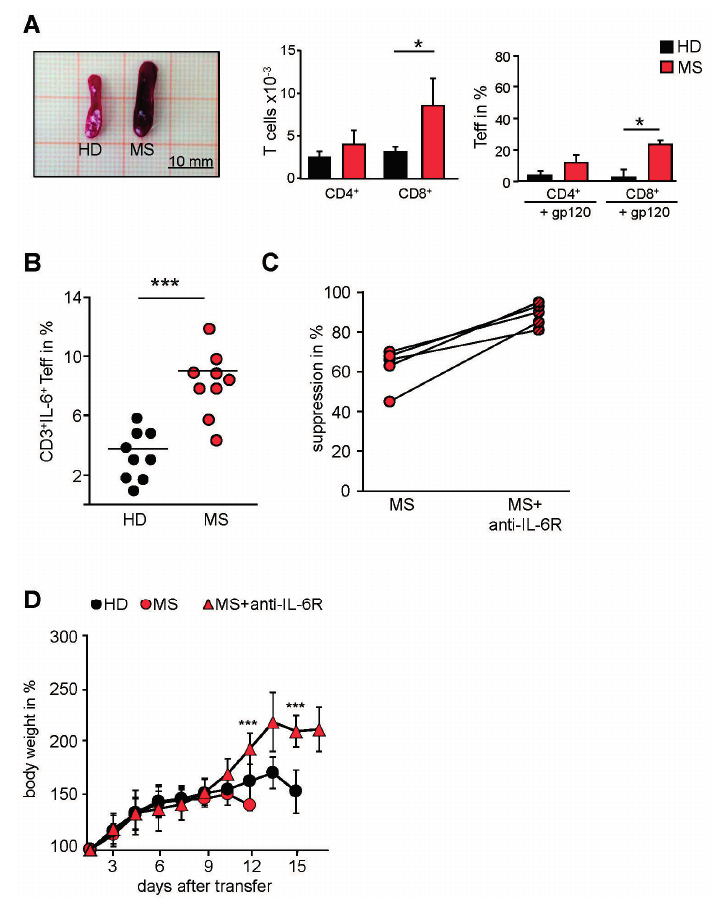
Figure 3. In vivo blockade of the IL-6 receptor by Tocilizumab ameliorated systemic inflammation. ( A ) Treg were depleted within PBMC of HD (black) or MS (red) and replaced with the same amount of Treg from an independent HD. Subsequently, 5 × 10 6 cells were injected with or without gp120 (5 μ g/mouse) intraperitoneally into newborn NOD/ Scid γ c − / − mice. Seven days after transfer spleens were removed and proportion of CD4 + and CD8 + T cells was analyzed by flow cytometry; p -values relative to mice injected with HD-PBMC: * p < 0.05; ( B ) MS PBMC were cultured in vitro with Treg and stimulated with anti-CD3 mAb in presence (striped) or absence (red) of anti-IL6R mAb. Dots show percentage of suppression in presence of Treg normalized to PBMC alone ( n = 5), *** p < 0.001; ( C ) Treg were depleted within PBMC of HD (black) or MS (red) and replaced with the same amount of Treg from an independent HD. Subsequently, 5 × 10 6 cells were injected with or without gp120 (5 g/mouse) intraperitoneally into newborn NOD/ Scid γ c − / − mice. Seven days after transfer spleens were removed and IL-6 production of reisolated T cells was determined by flow cytometry. Each point represents an individual mouse, line indicates mean value; ( D ) Treg were depleted within PBMC of HD (black) or MS (red) and replaced by the same amount of Treg from an independent HD. Subsequently, 5 × 10 6 cells were injected with or without 10 g/mouse anti-IL-6R (Tocilizumab) intraperitoneally into newborn NOD/ Scid γ c − / − mice. Each point represents the cumulative mean weight of one group (five mice per group). Two of three independent experiments are shown. *** p <